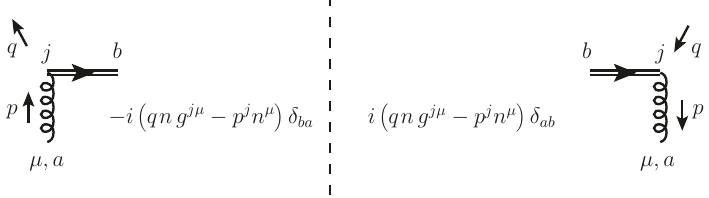
Figure 14. Feynman rule corresponding to the operator in a gluon distribution when an eikonal line along n is attached to the gluon. The Lorentz index j is transverse w.r.t. the lightlike direction n